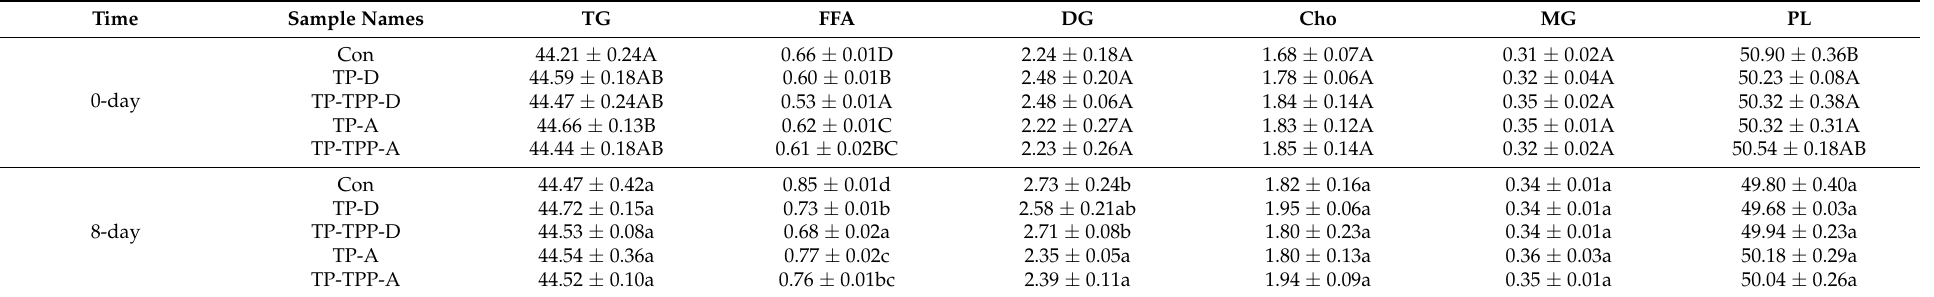
Table 4. The lipid composition (relative content, %) of krill oils added with different antioxidants in the accelerated storage at 60 ◦